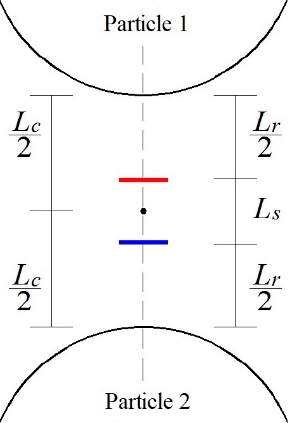
Figure 2. Schematic diagram of the gap between particles. When the bond between particles is activated, the force-displacement law will be followed, as shown in Equations (2) and (3):